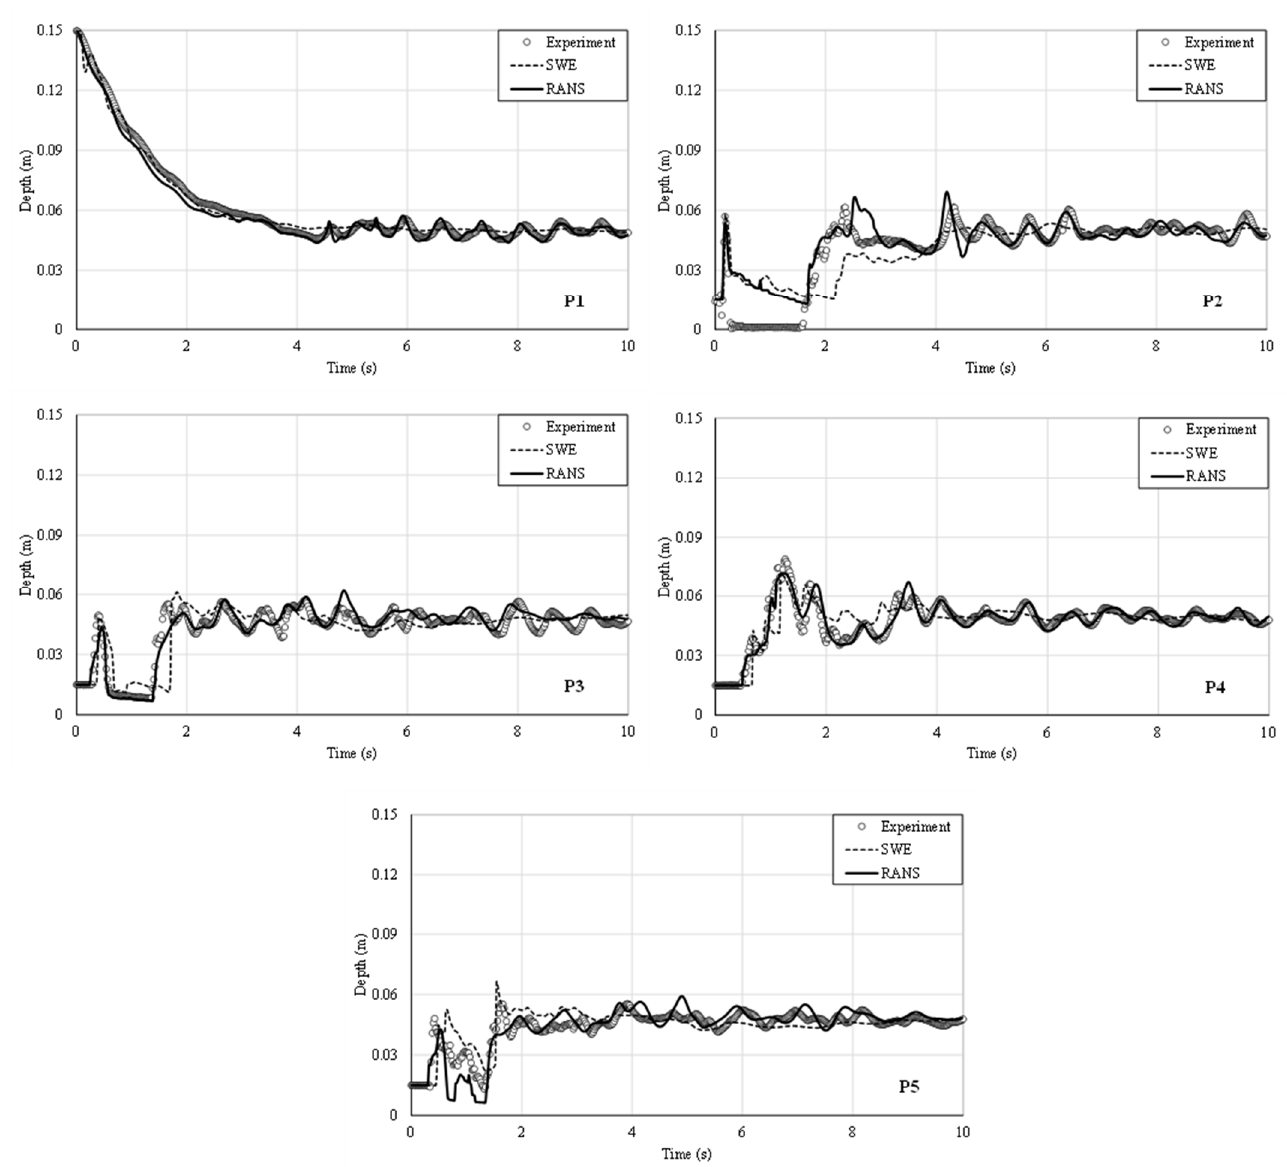
Figure 9. Comparison of experimental and numerical stage hydrographs (P1–P5 sensors) for test W1.